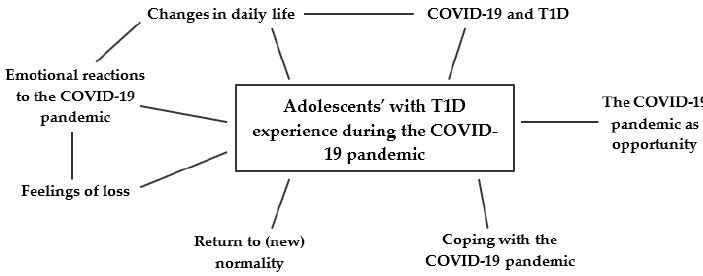
Figure 2. Themes highlighted and relative connections.